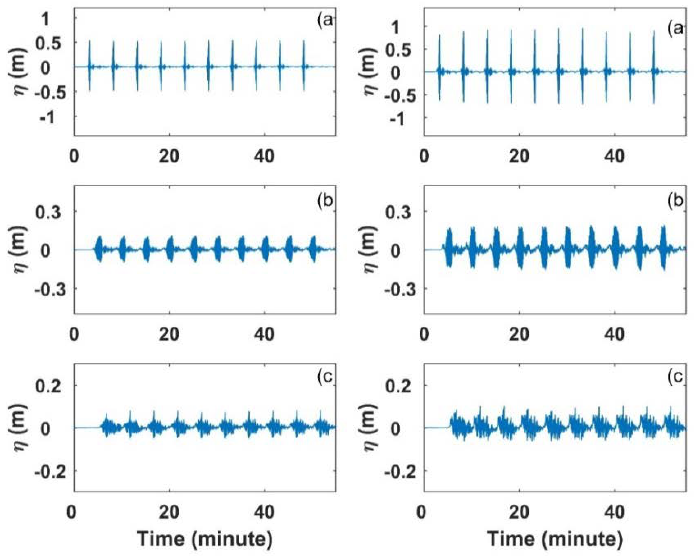
Figure 6. Time series of water surface elevation at stations a, b, and c along transect-1. Results are for experiments with 10 small (left) and 10 large (right) vessels with a sailing speed of 15 knots (i.e., experiments 8 and 4). The time between each vessel entering the study area is 5 min. J. Mar. Sci. Eng. 2020 , 8 , x FOR PEER REVIEW